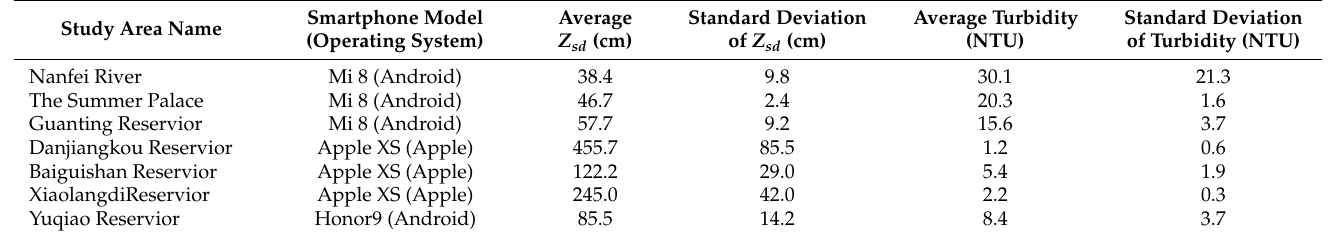
Table 2. Summary of smartphone models used for photography and water quality parameters in the study